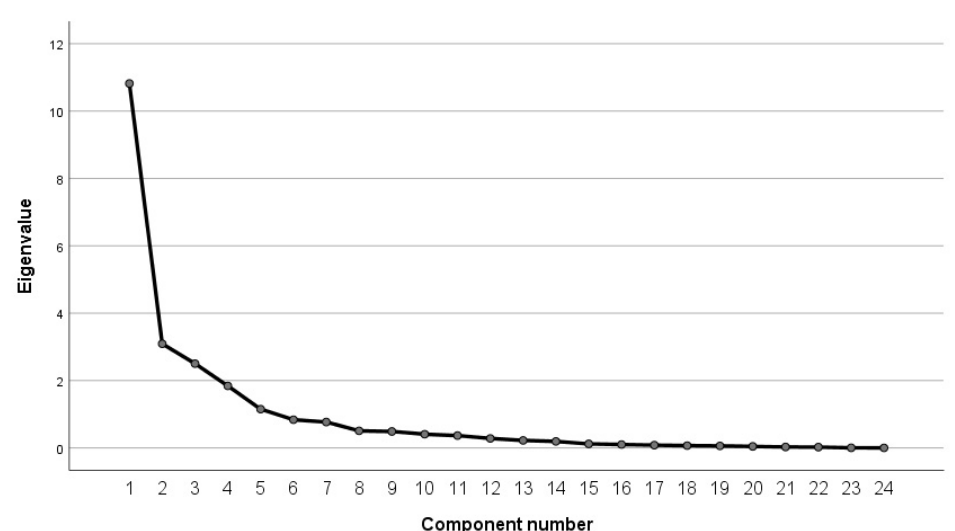
Figure 5. Lithograph of the vehicle driving experimental data. Table 4. Total explained variance of the vehicle driving experimental data.